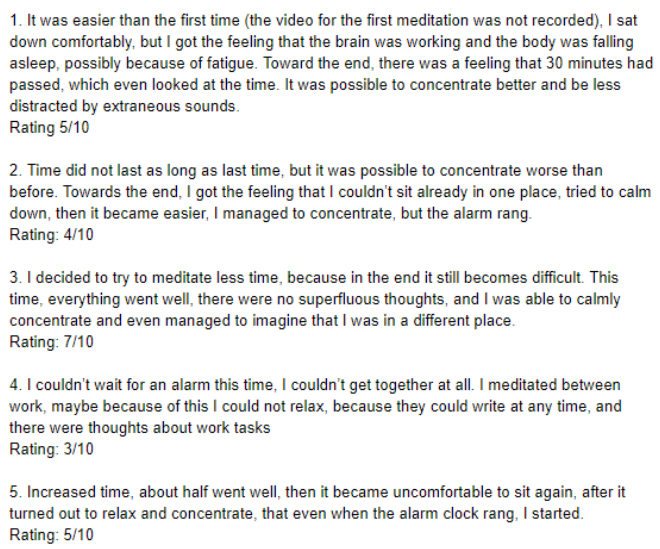
Figure 11. Dataset example: Meditations feedback by one of meditators.